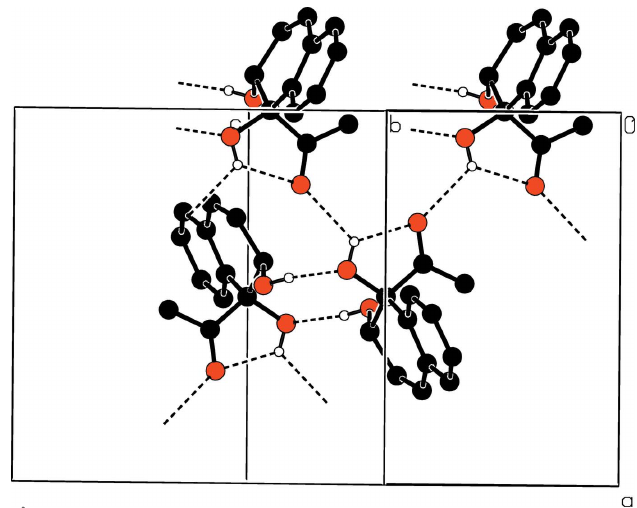
Figure 3 Part of the crystal structure of the title compound with hydrogen bonds shown as dashed lines.